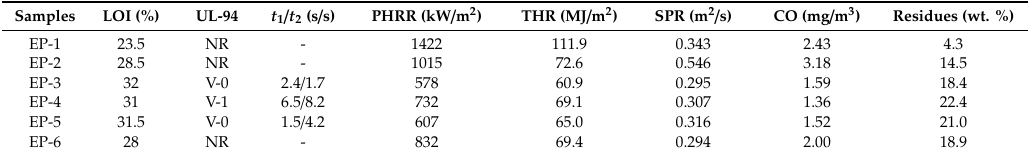
Table 3. LOI, UL-94 rating, and cone calorimeter data of cured epoxy resin and its composites.